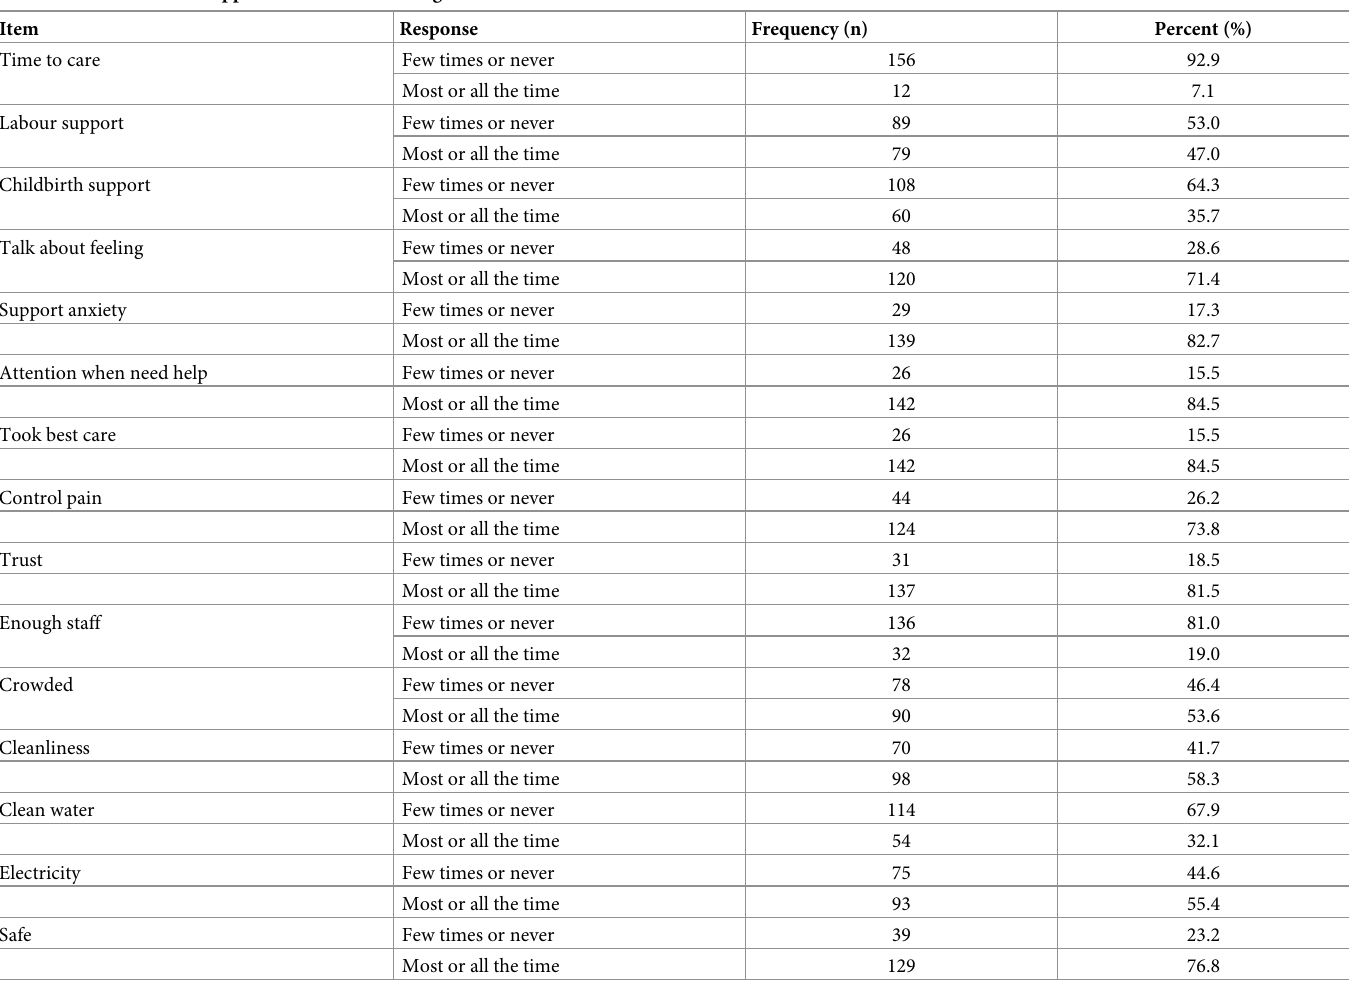
Table 4. Distribution of supportive care items among